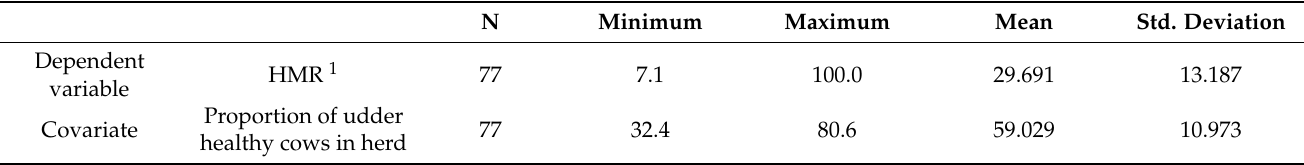
Table 2. Continuous variable information.